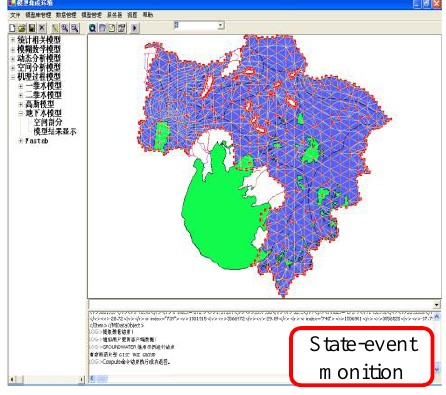
Figure 12 Ground water model execution